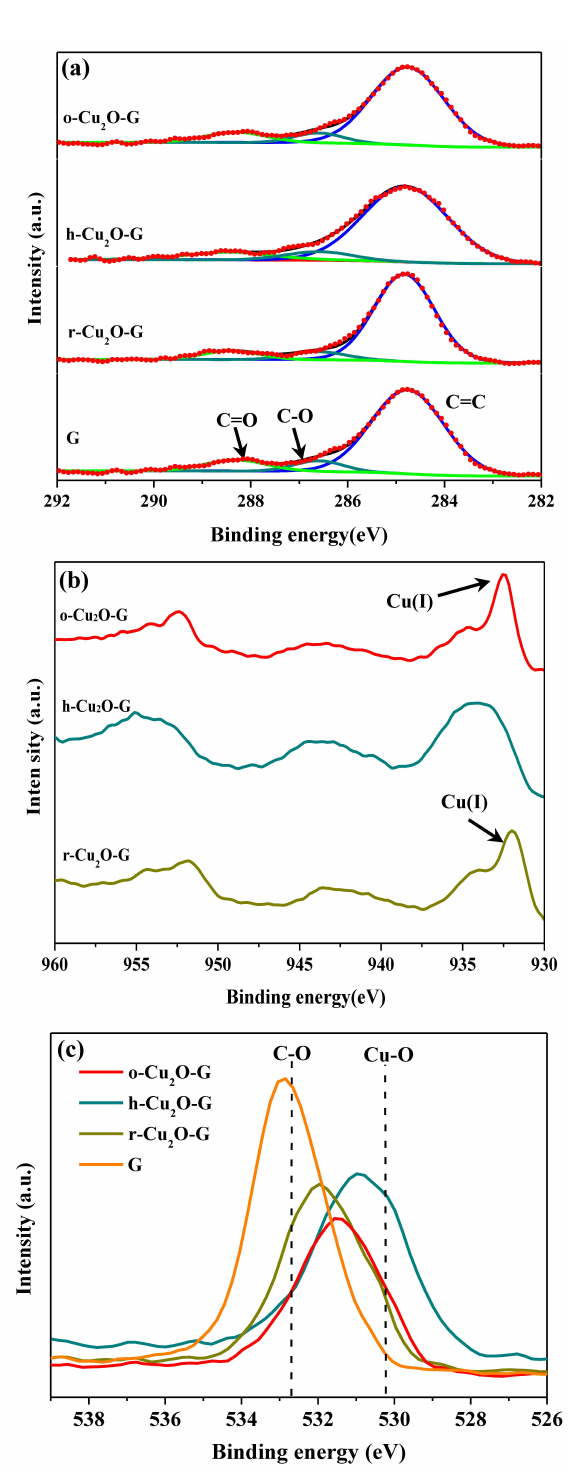
Figure 4. X-ray photoelectron spectroscopy (XPS) spectra of different photocatalysts at the ( a ) high-resolution C 1s core-level; ( b ) Cu 2p core-level; and ( c ) O 1s